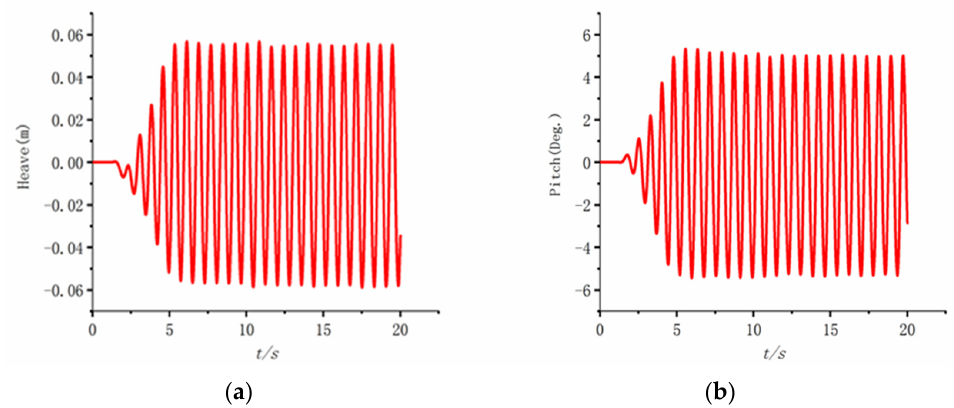
Figure 18. Time history curve of “Yukun” hull at V = 16.7 knots (Case CY4). ( a ) Heave; ( b ) Pitch.